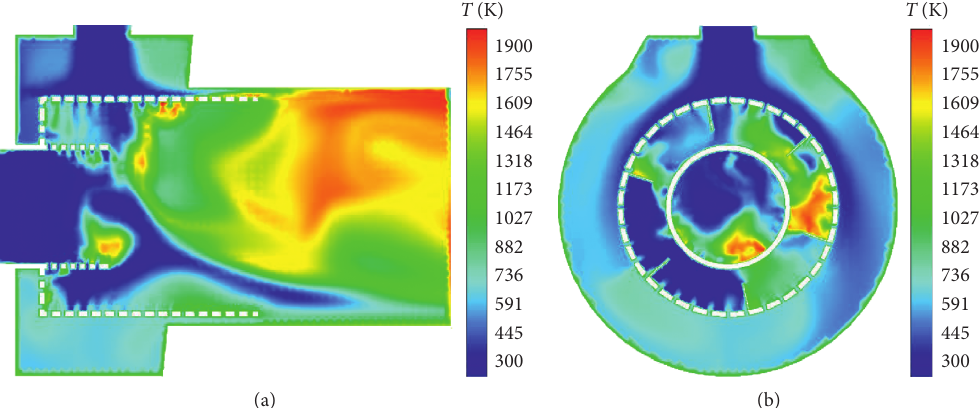
Figure 4: Temperature distribution of the gas phase in the burner. (a) Longitudinal distribution ( α � 1.2). (b) Horizontal distribution ( α � 1.2) ( Y � 0.364m).